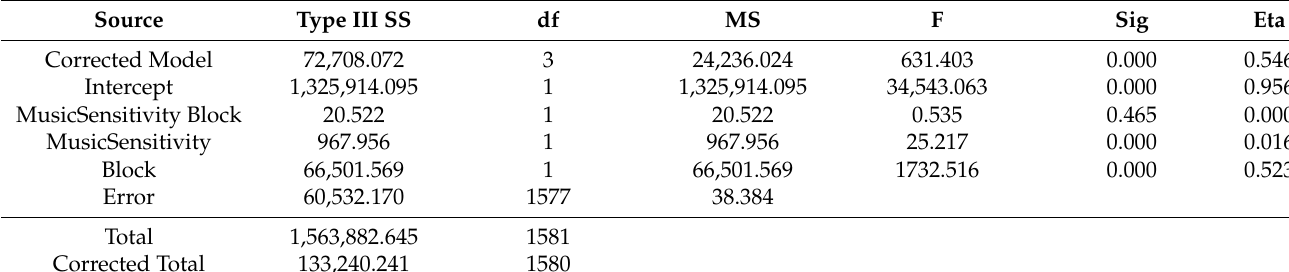
Table A2. Two-way ANOVA on the influece of music sensitivity per block.